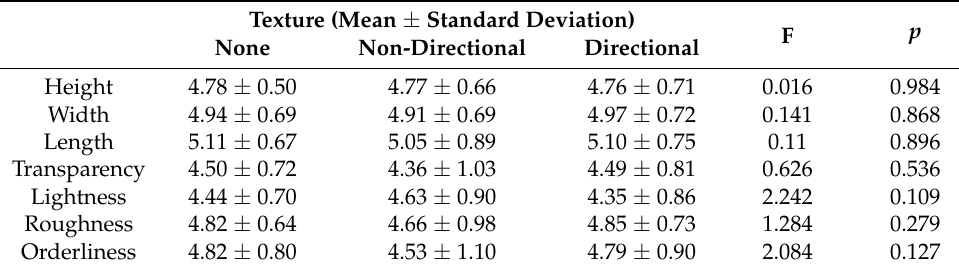
Table 14. Variance analysis of texture